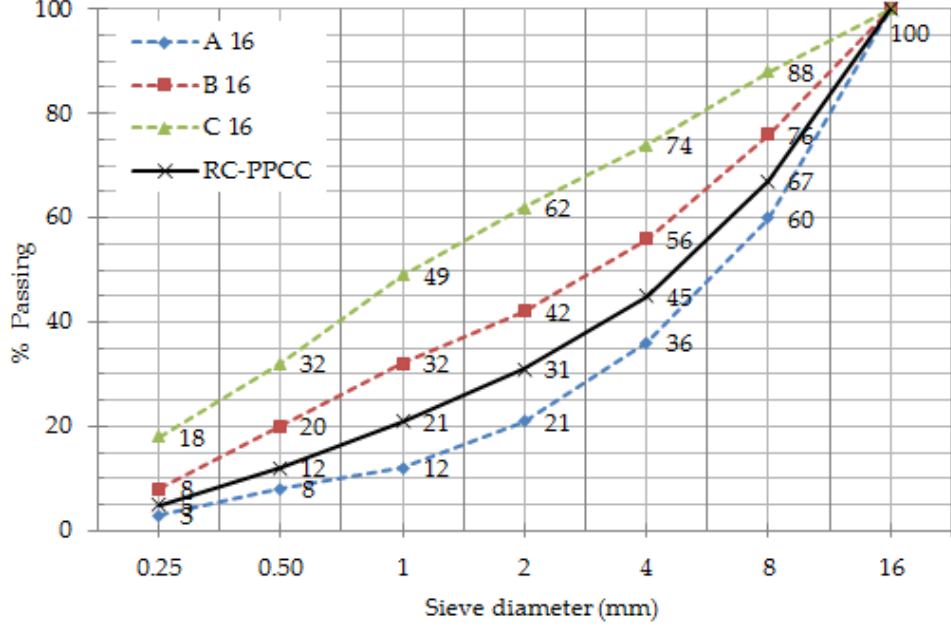
Figure 12. Reference concrete (RC) and optimum binder concrete (PPCC) sieve analysis chart.